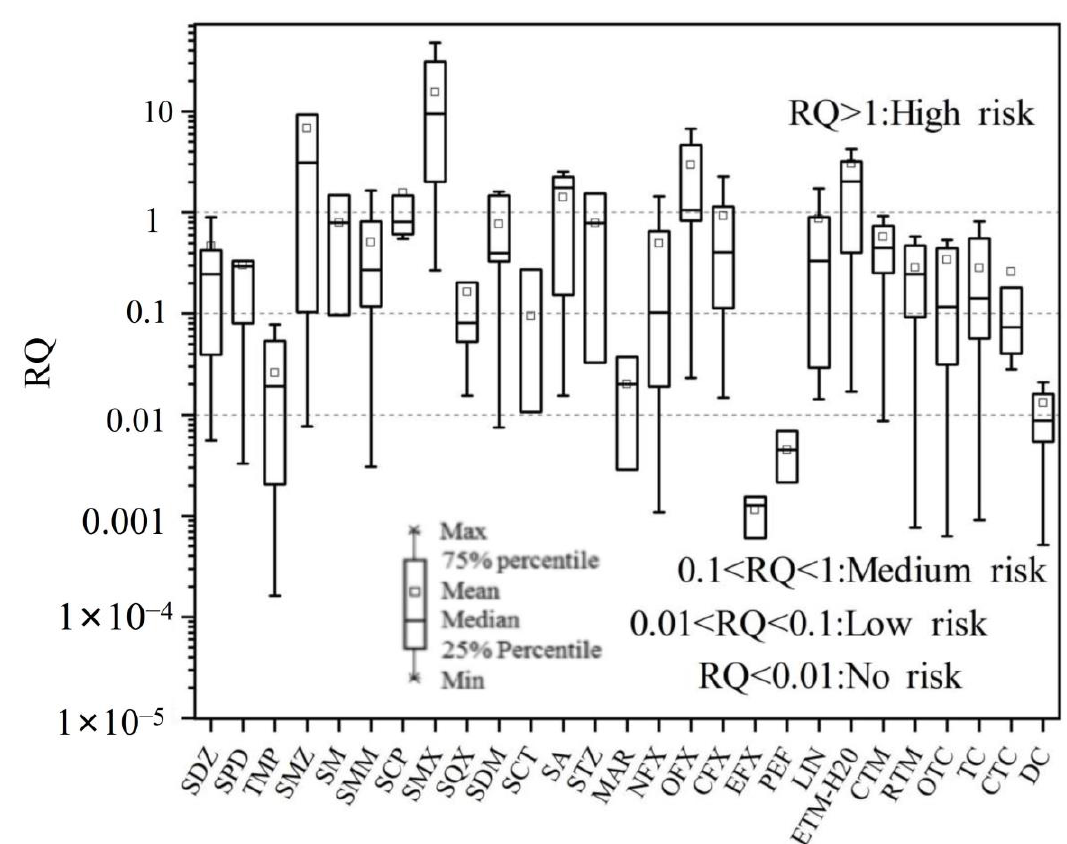
Figure 6. Risk quotients (RQs) for 27 target antibiotics in the pharmaceutical plant effluents